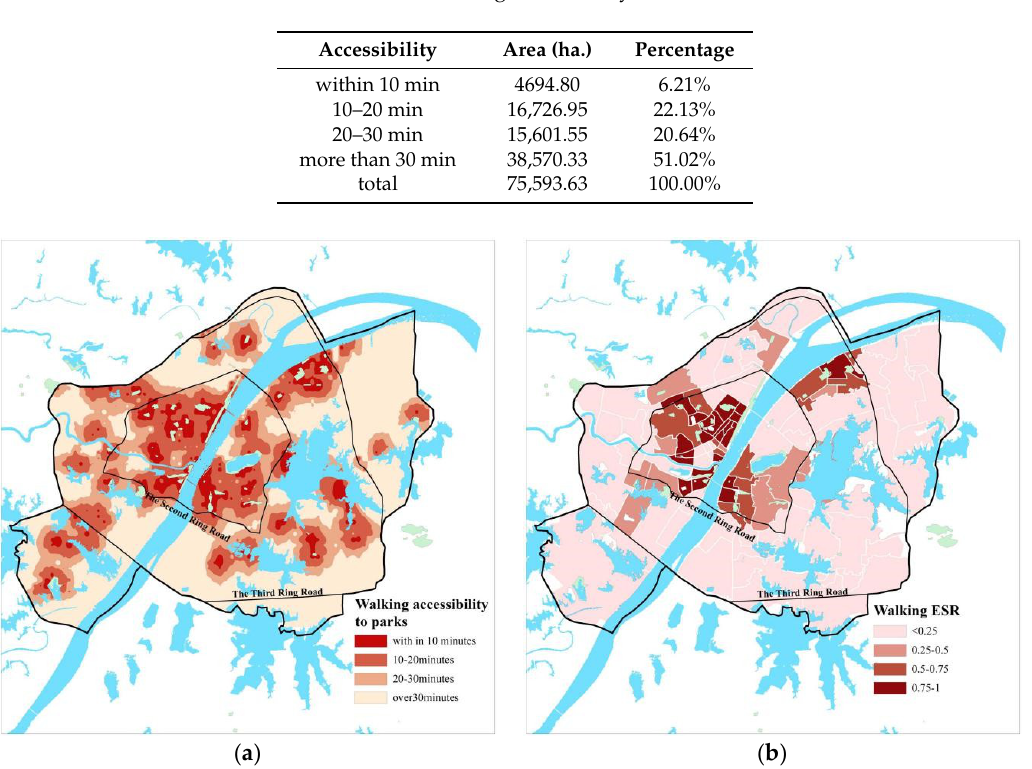
Figure 3. ( a ) Spatial distribution of walking accessibility to parks; ( b ) Spatial distribution of walking ESR.